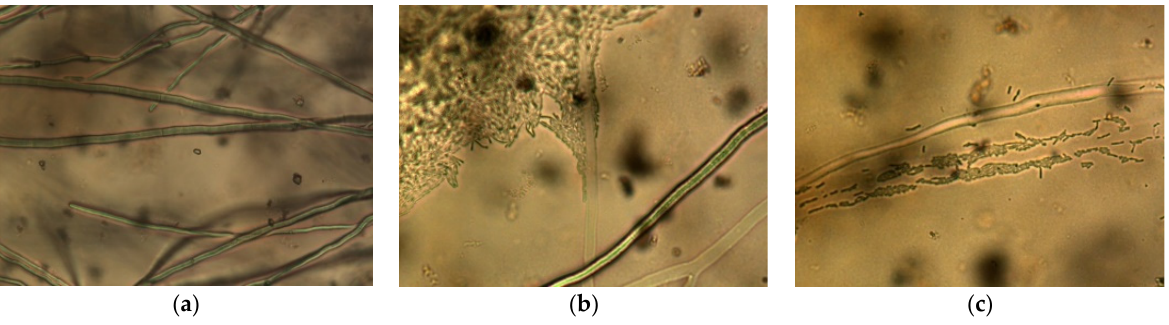
Figure 5. F. graminearum BZR 4: ( a )—control ( F. graminearum BZR 4 without antagonist bacterium); ( b )—colonization of B. velezenzis BZR 336 g hyphae F. graminearum BZR 4; ( c )—hyphae lysis of F. graminearum BZR 4 during incubation with antagonist bacterium B. velezenzis BZR 336 g, ×400 mag-